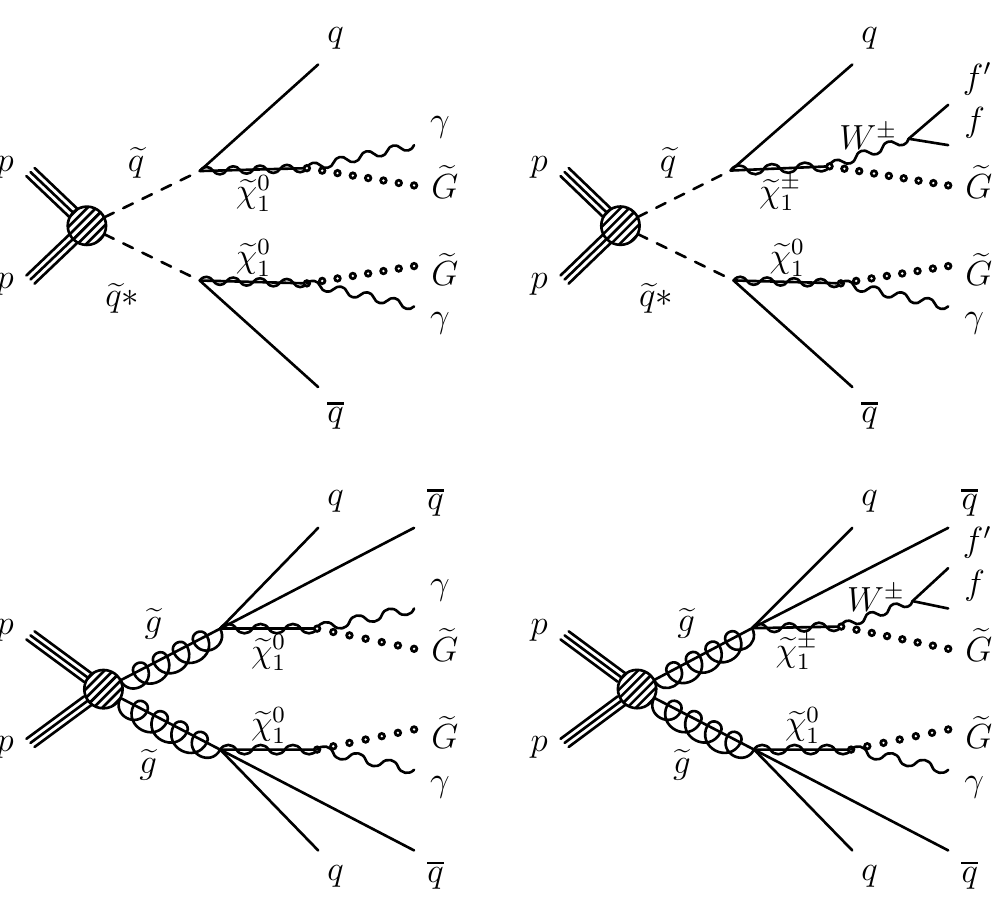
Figure 1 . Feynman-like diagrams for the T6gg (top left) and the T5gg (bottom left) processes, and representative Feynman-like diagrams for the T6Wg (top right) and T5Wg (bottom right) processes. The T6Wg and T5Wg models include also diagrams with either two photons or two W bosons in the (cid:12)nal